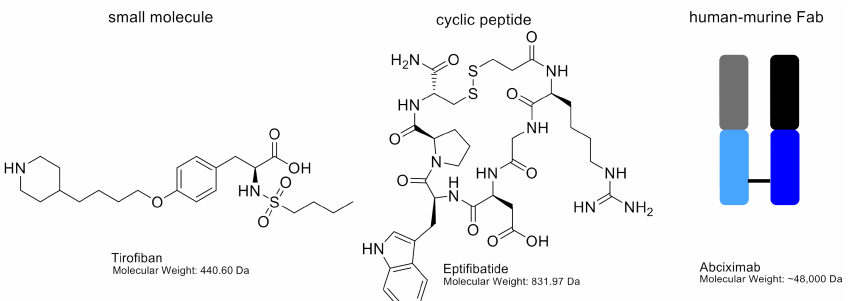
Figure 5. Chemical structures of tirofiban and eptifibatide, including molecular weights. Abciximab is shown as a schematic figure. The murine variable chain region is shown in grey (light chain) and black (heavy chain). The human constant regions are shown in light blue (light chain) and dark blue (heavy